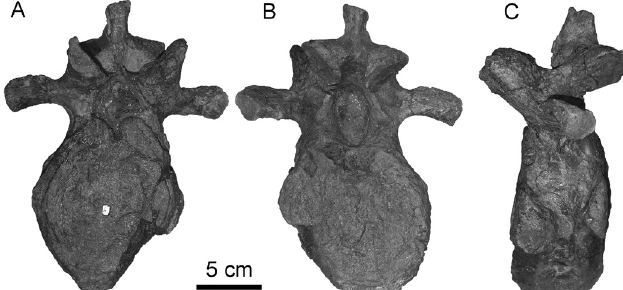
Figure 4. Fourth cervical in anterior, posterior, and left lateral views. Vagaceratops irvinensis , CMN